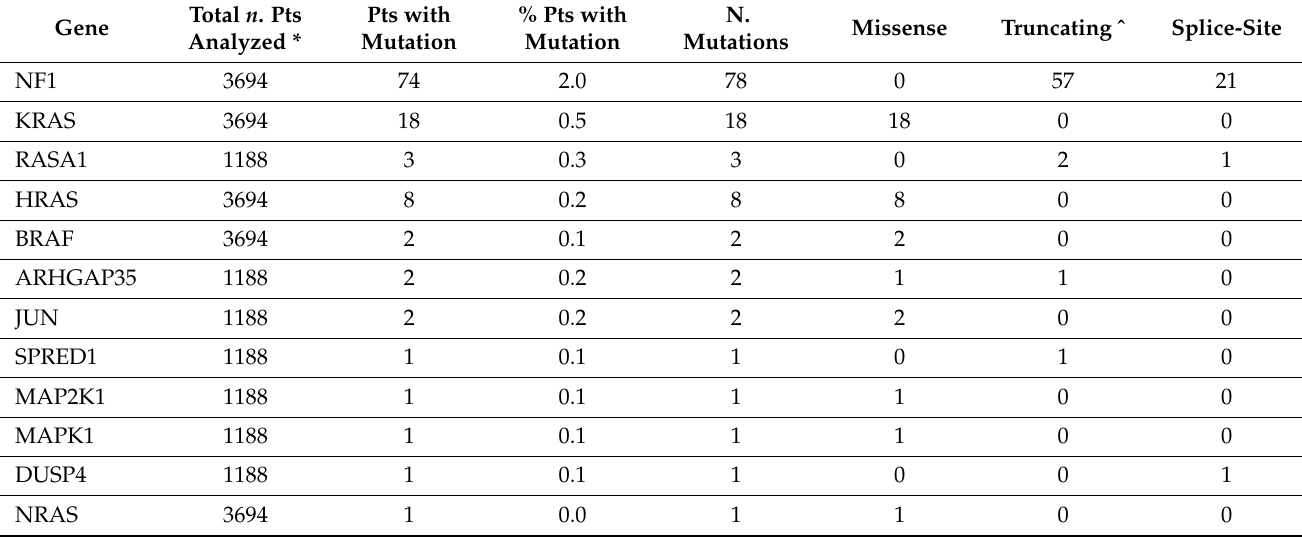
Table 3. Mutations of RAS/RAF/MEK/ERK pathway genes in primary breast carcinoma samples of 3694 patients from three studies (METABRIC, TCGA, CPTAC). Total n . Gene